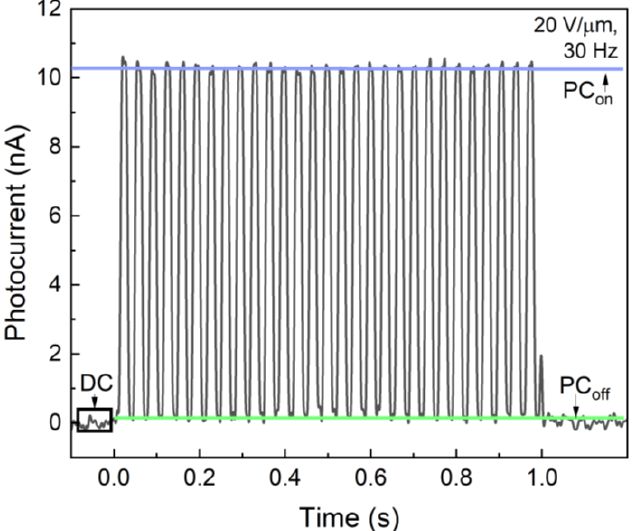
Figure 5. A typical photocurrent of the PI/a-PbO detector due to modulated irradiation.